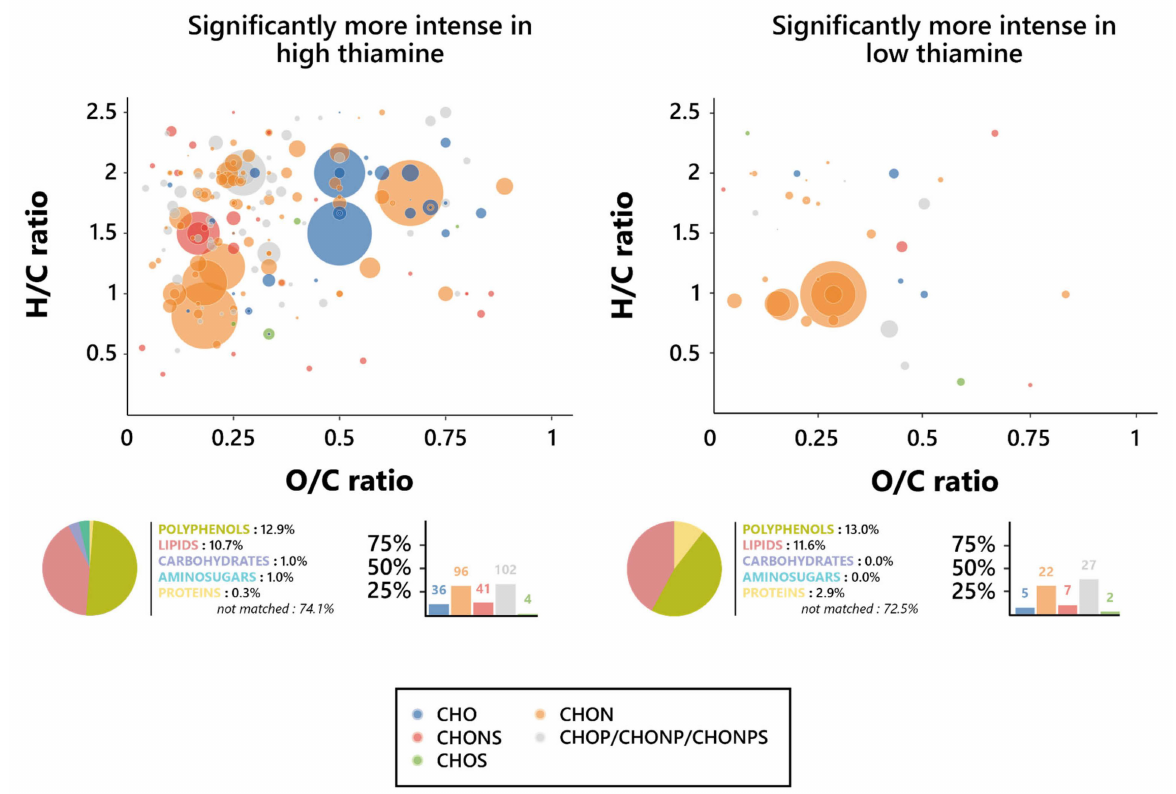
Figure 5. Metabolomic foot-printing of S. cerevisiae grown in high or low thiamine conditions based on LC-MS-MS untargeted analysis data. Van Krevelen diagrams based on the H/C and O/C atomic ratios for the significantly more intense features (extracted through ANOVA; p < 0.01), histogram proportion of their elemental compositions, and pie chart distribution of the predicted families for these biomarkers in high thiamine conditions ( left , 378 markers) and low thiamine conditions ( right , 79 markers). The point size indicates the relative intensity of the extracted